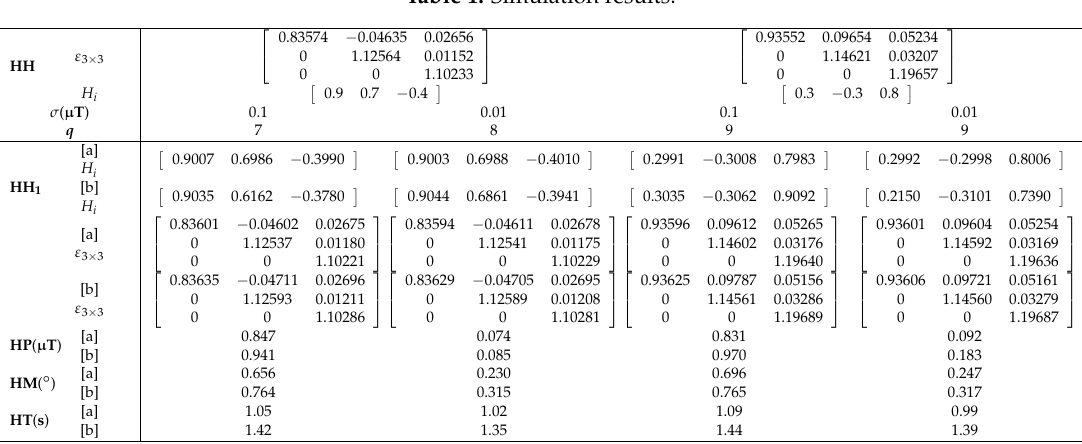
Table 1. Simulation results.